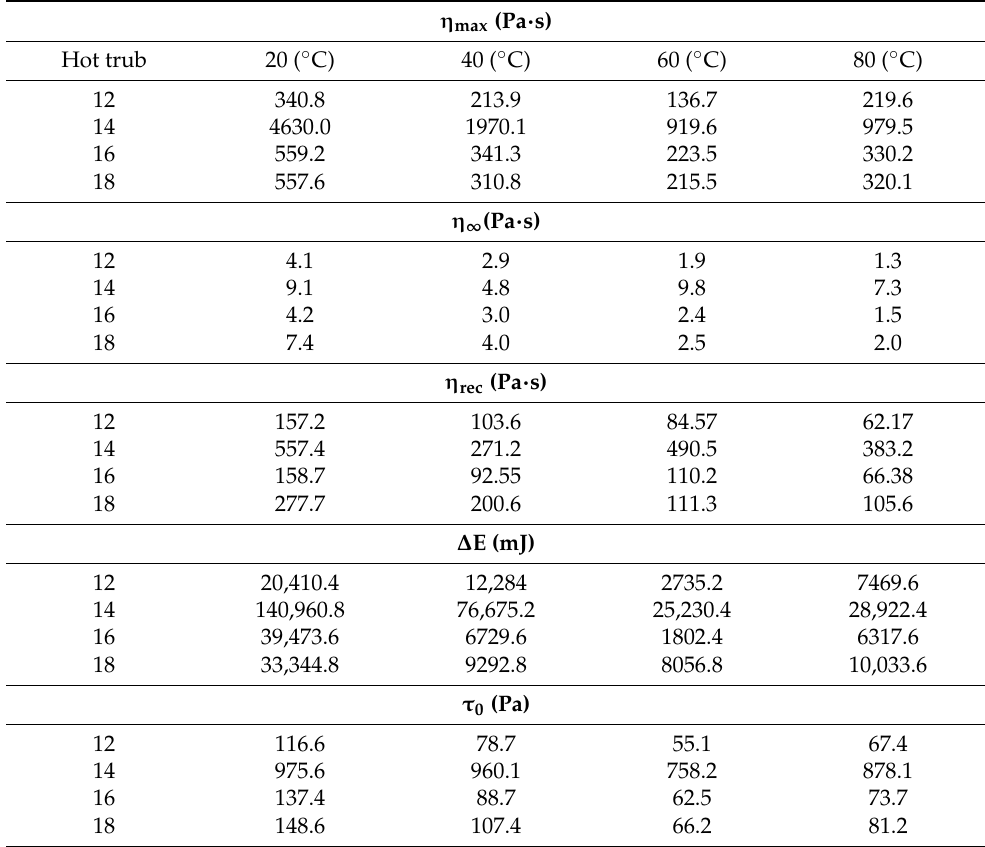
Table 2. Experimentally obtained values of limit, maximal, and recovery viscosity values, energy dissipated, and yield stress for hot trubs at different